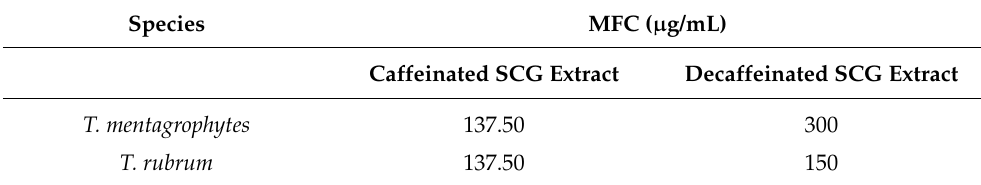
Table 3. Minimum fungicidal concentration of caffeinated and decaffeinated SCG extracts against T. mentagrophytes and T. rubrum . Three independent experiments were performed. Species MFC ( µ g/mL) Caffeinated SCG Extract Decaffeinated SCG Extract